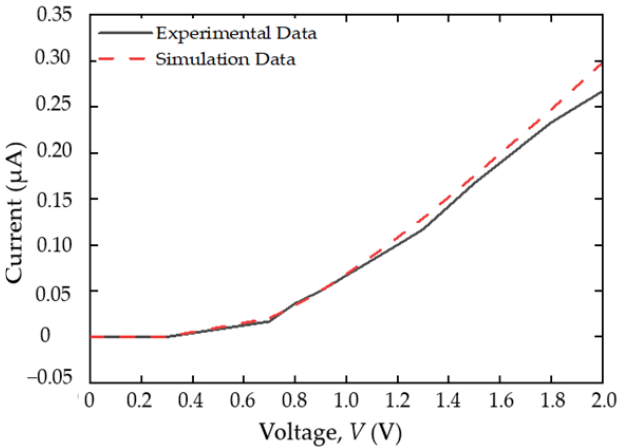
Figure 3. Comparison of IV characteristics between simulation and experimental data of Farhi et al. [32,35].